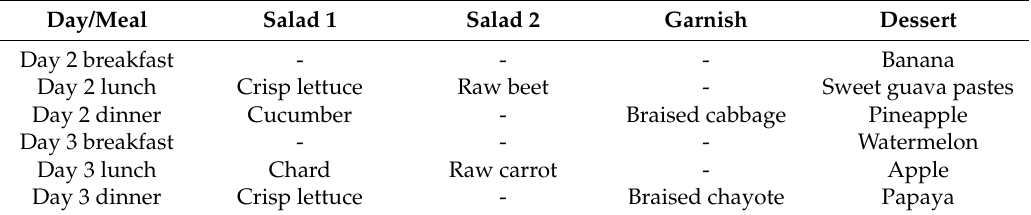
Table 6. The qualitative offer of fruits and vegetables at the University Restaurant